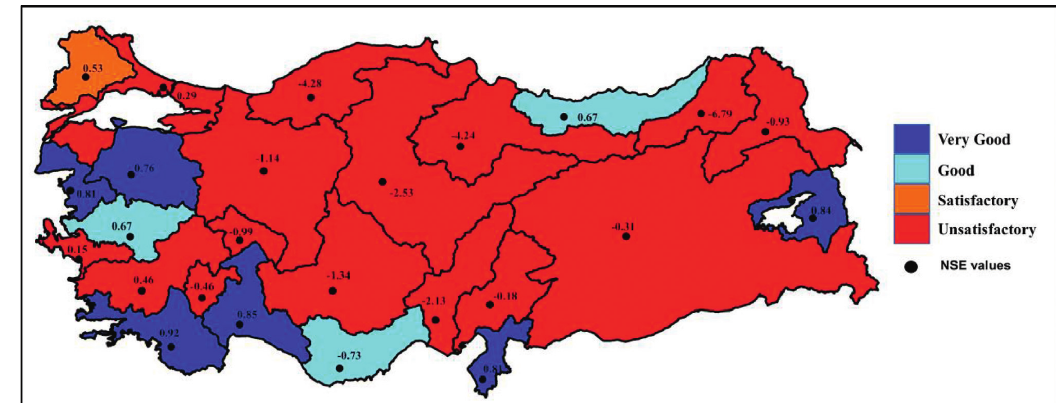
Figure 8: Results of NSE evaluation for TRMM